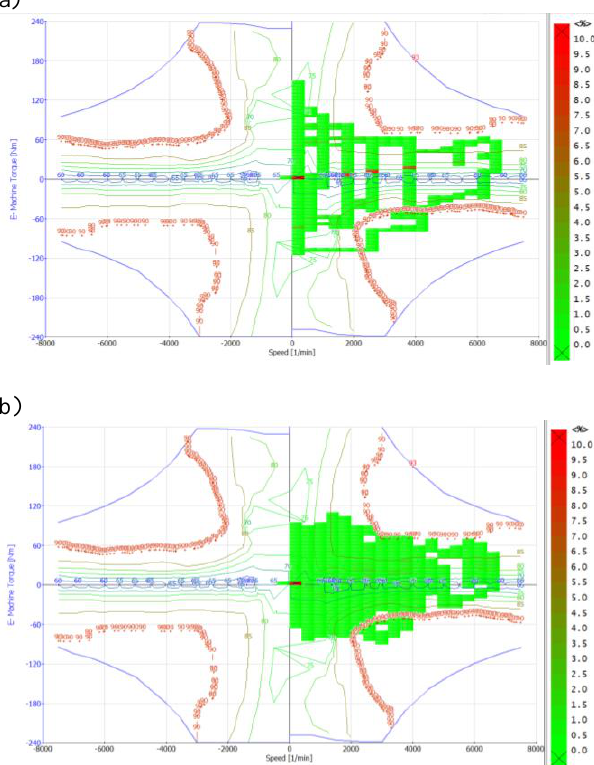
Fig. 7. Electric motor load : a) in the NEDC test, b) in the WLTC test efficiency range. In both cited cases, the use of the braking torque in the efficiency range above 90% was